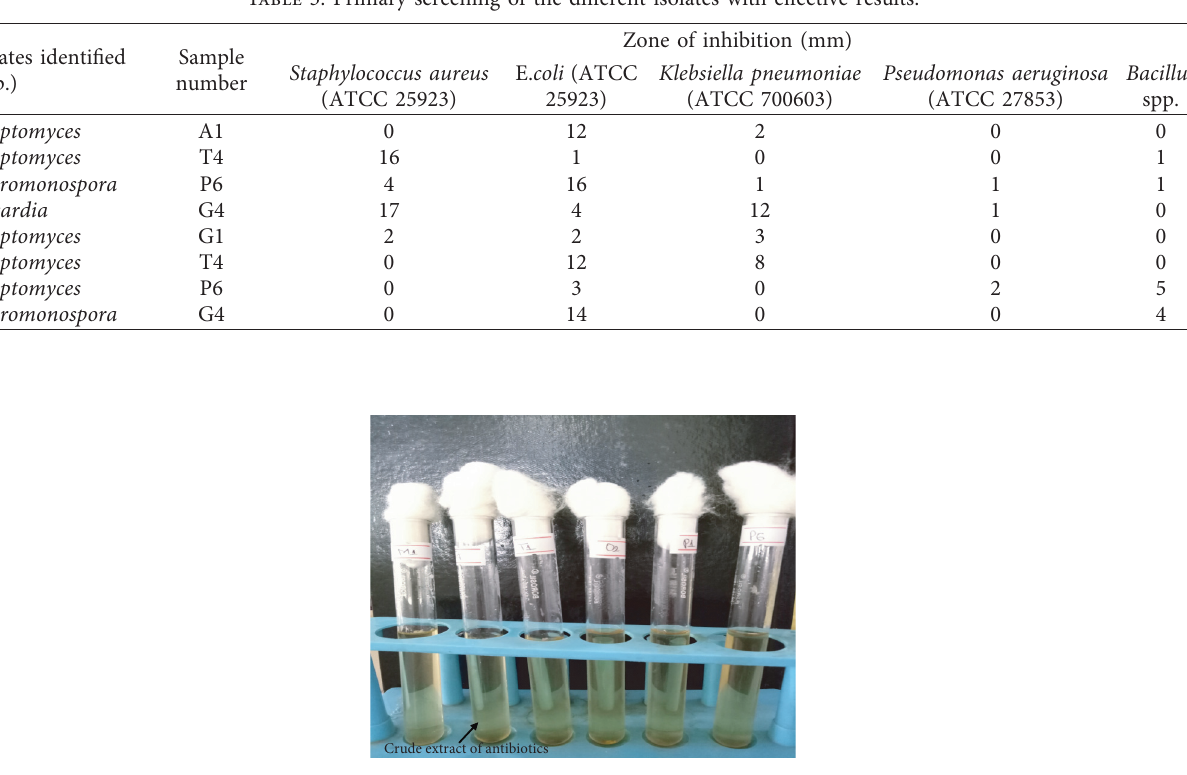
Figure 6: Crude extract of antibiotics. Test tube with the crude form of antibiotics following secondary submerged-state fermentation.